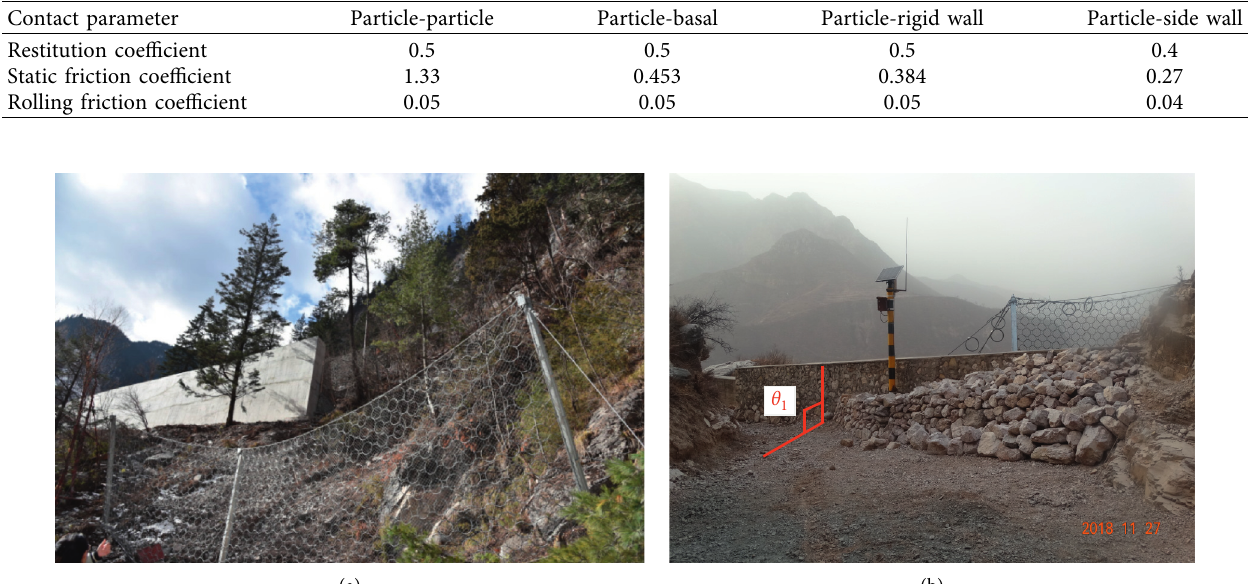
Figure 6: The rigid wall installed in the gully and on the slope: (a) slope and (b) Gully (Xiao et al. 2019).